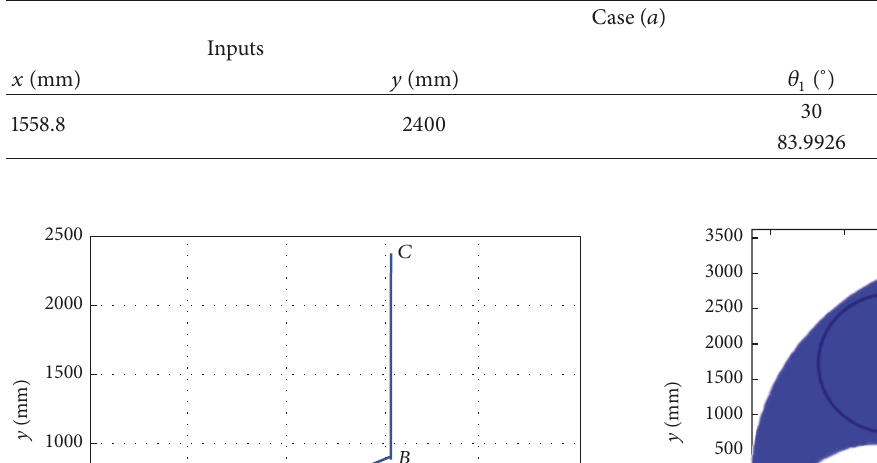
Table 2: Inverse position analysis for the robot.